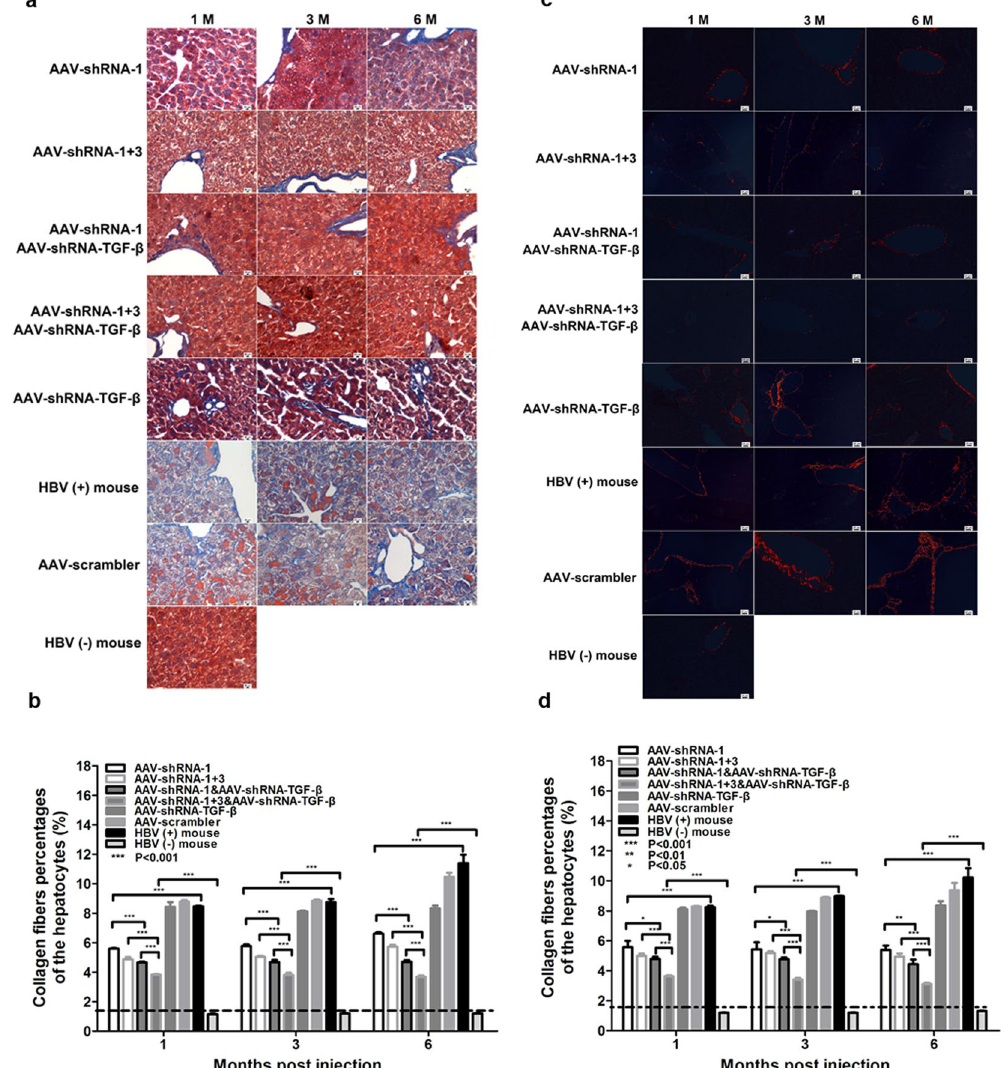
Figure 8. AAV-shRNA treatment attenuates collagen deposition and liver fibrosis in HBV-persistent mice. Mice received AAV2-shRNA treatment and were euthanized at 6 months post vector administration. Collagen deposition and collagen fibers were examined by Masson’s trichrome ( a ) and Sirius red staining ( c ) of the liver sections, respectively. Sirius red staining was observed under polarizing microscope. Ten random fields were selected per slide, and the percentages of hepatocytes with collagen deposition ( b ) and collagen fibers ( d ) were quantified using Image-Pro Plus. P < 0.05: significant difference, Data represent the mean ±